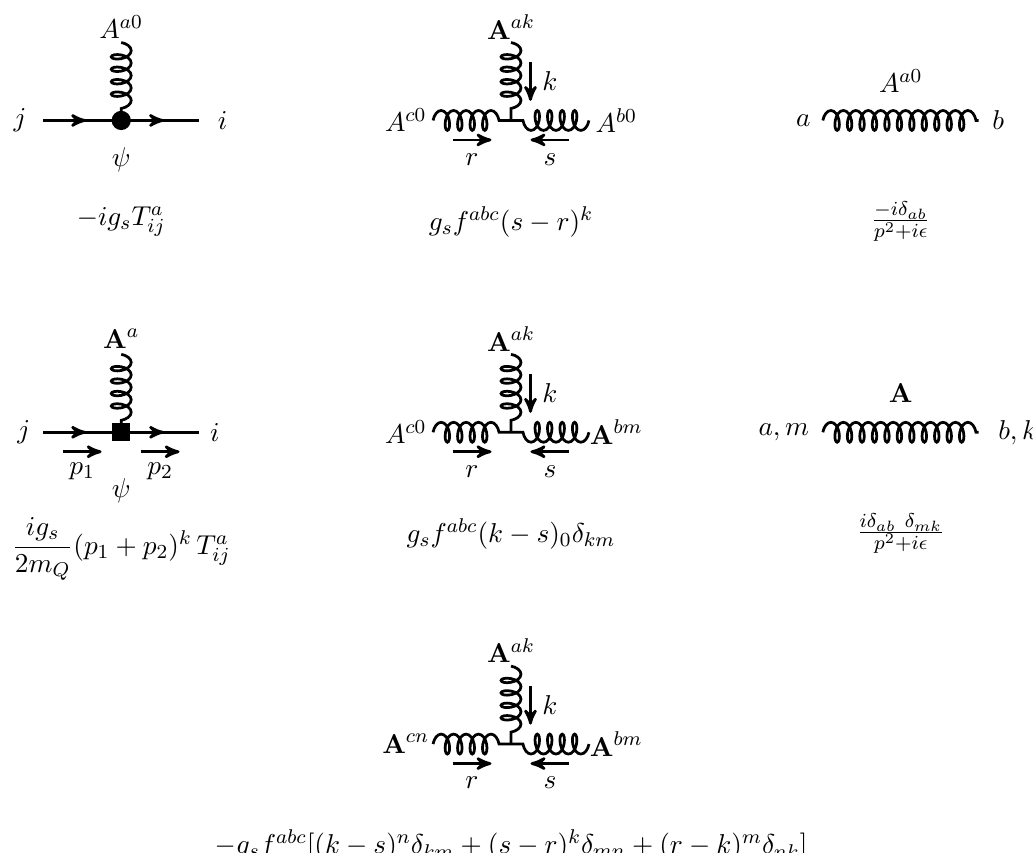
Figure 8. Feynman rules that are used to derive the non-relativistic potential that determines the radiative capture into bound states. In the gauge (cid:12)elds A a;(cid:22) , the (cid:12)rst index denotes colour, while the second one if the space-time index. The (cid:12)rst column depicts the NRQCD Feynman rules which distinguish between temporal (black dot) and spatial (black rectangle) couplings in the quark-gluon vertex.